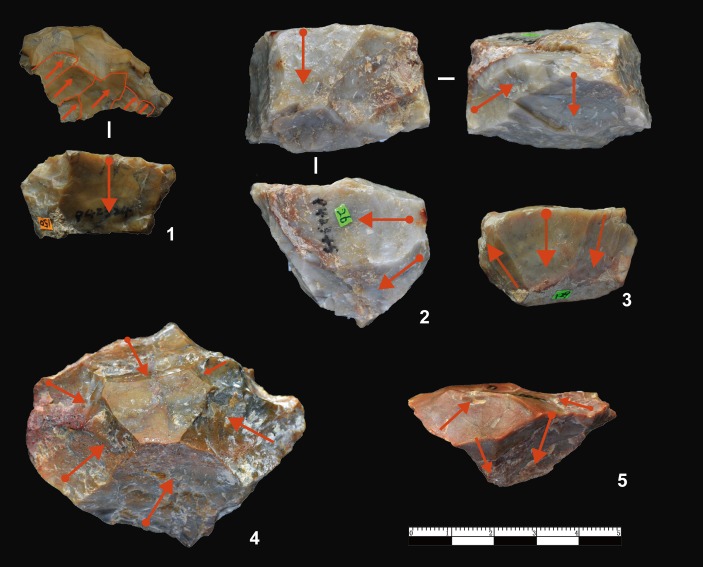
Core types identified at DGT.No. 1 is a Unidirectional core with a faceted platform, showing a series of negative flake scars on a single edge; No. 2 is a Multidirectional core; No. 3 is a bipolar exploited core with two opposed flaking directions; Nos. 4 and 5 are bifacial cores showing alternate flaking patterns.